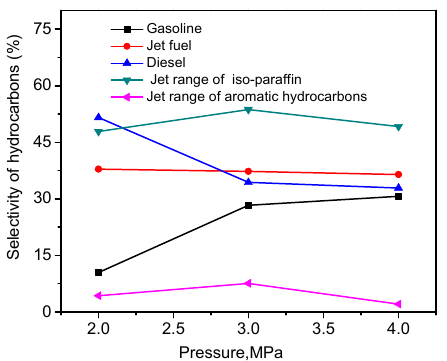
Figure 7. Selectivity for the formation of hydrocarbons using NiMo/SBUY-MCM-41 at different pressures. Reaction conditions: 380 °C, 500 mL/mL.